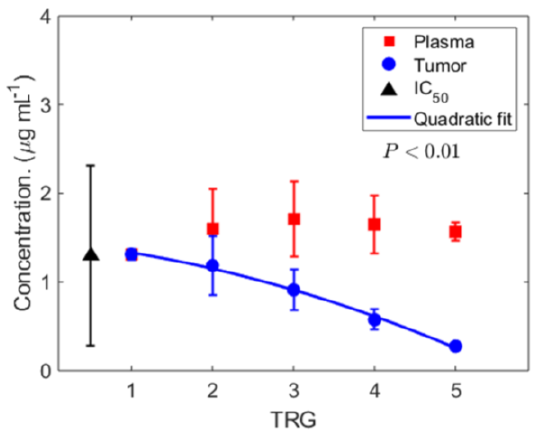
Figure 4. Calculated chemotherapy concentration and response to therapy. Calculated time-averaged plasma concentration σ B, i (red squares) and estimated time-averaged tumor-site concentration of chemotherapy (cid:104) σ T (cid:105) (blue squares with best fit, p value < 0.01, R 2 = 0.98) throughout the course of multiple cycles of treatment is predicted by PK analysis and the mathematical model. Note that (cid:104) σ (cid:105) < σ B, i , and in particular for TRG = 5, the average tumor concentration is ~5.7 times smaller than the corresponding average plasma concentration, nearly matching the lower bound of IC 50 for 5-FU. Data represents mean ± standard deviation (SD). (Patient cohort size, n = 33).